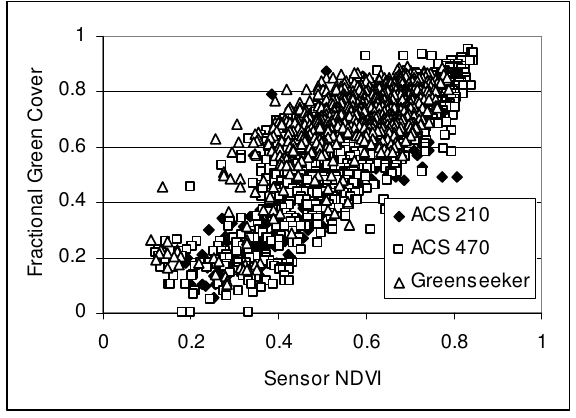
Figure 1. Fractional Green Cover (measured) plotted against the mean NDVI measured by plot, for all datasets (N=2355). The regression fitted yield r 2 = 0.70 and a